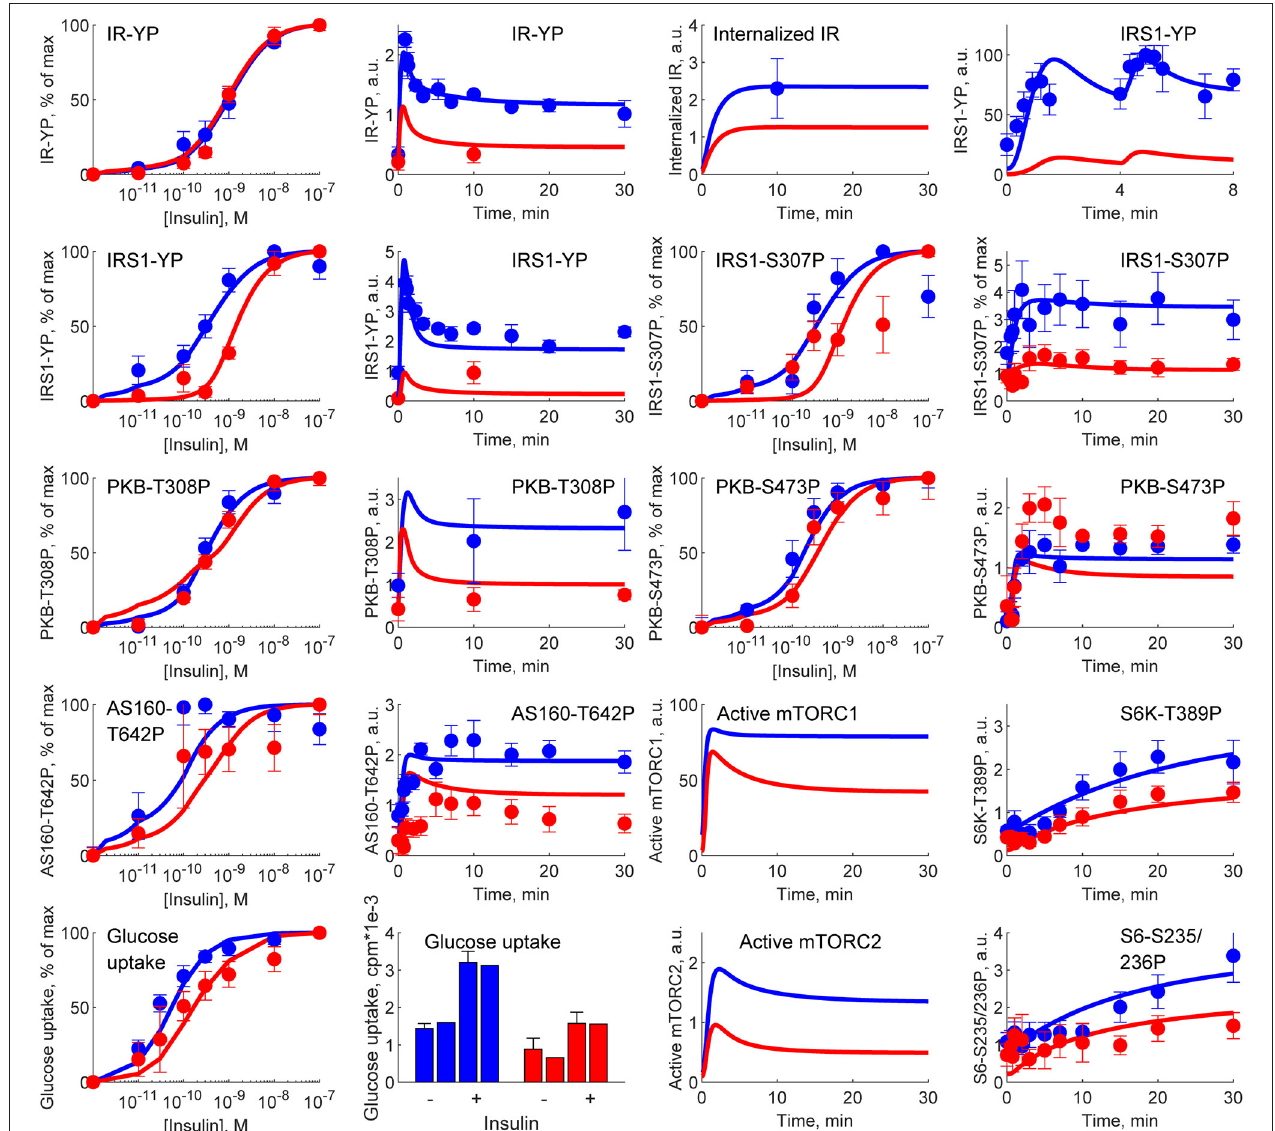
FIGURE 7 | Simulations of M4 (lines) in comparison with experimental data (error bars) from Brännmark et al. (2013). M4 can describe data for intracellular insulin signaling in adipocytes, both normally (blue) and in T2D (red). IR, insulin receptor; IRS1, insulin receptor substrate-1; PKB, protein kinase-B; AS160,